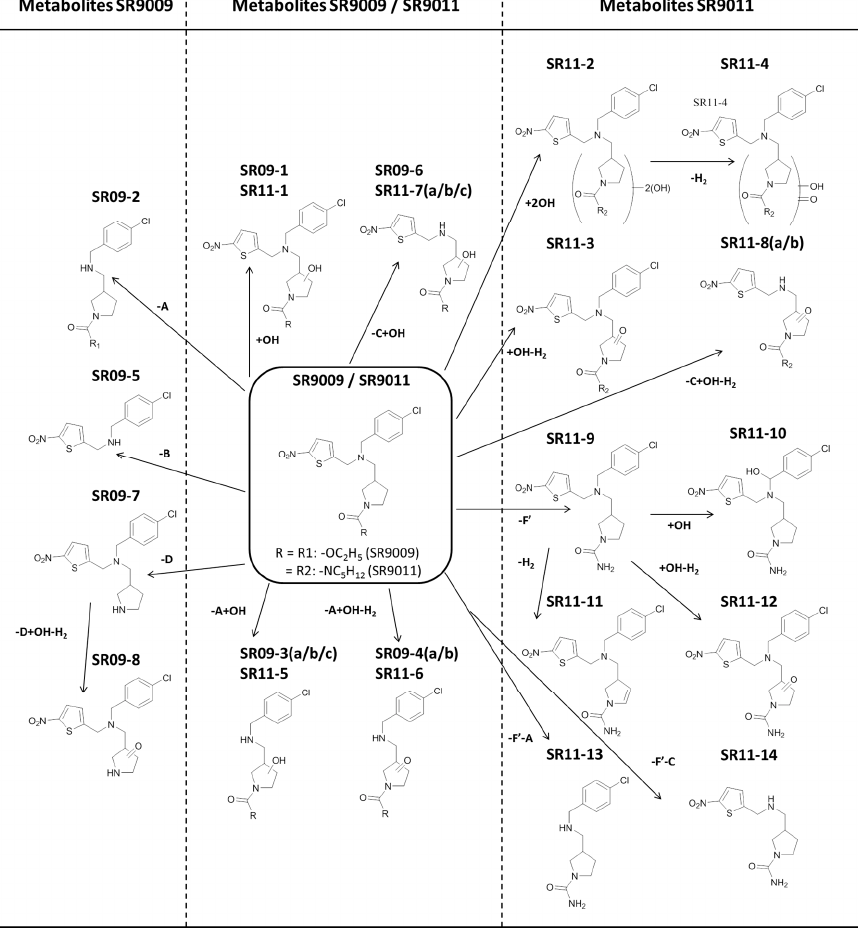
Figure 6. Overview of in vitro metabolic studies with SR9009 and SR9011. The proposed metabolic modifications are also presented; the structures of A, B, C, D and F’ are indicated in Figure 1 and Table 1. For the position of hydroxylations, only one possible configuration is